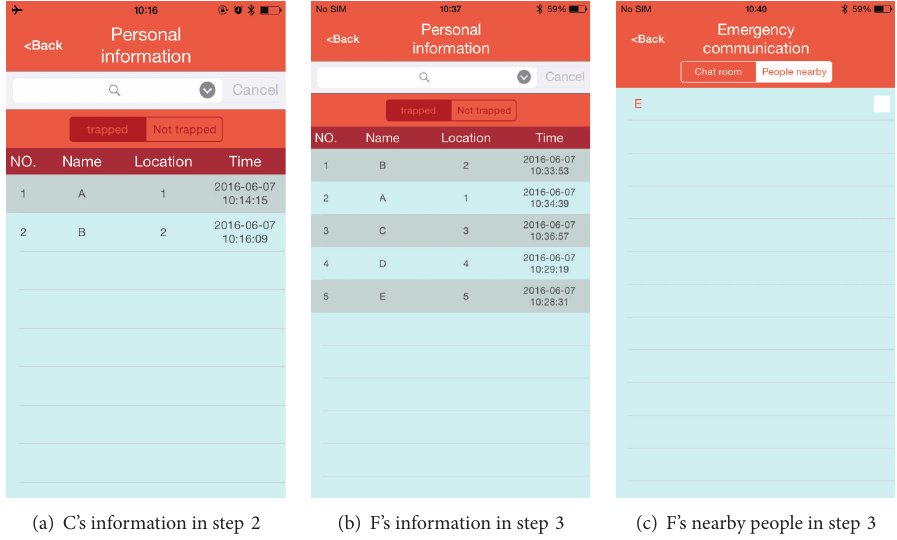
Figure 11: Results of dense node experiment.